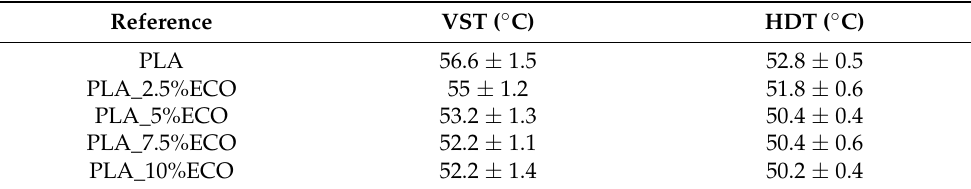
Table 2. Vicat softening temperature (VST) and heat deflection temperature (HDT) of PLA with different epoxidized chia seed oil (ECO) content.